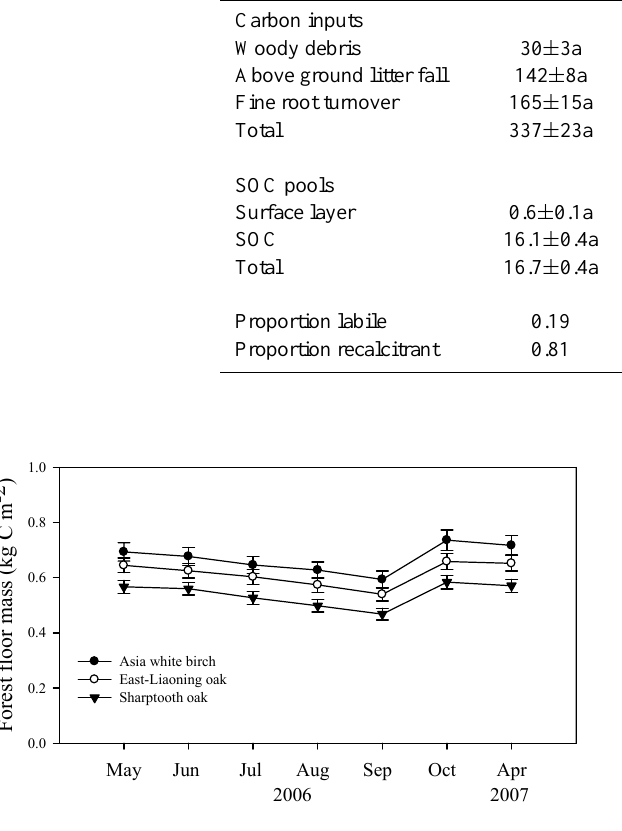
Fig. 1. Seasonal changes of forest floor mass in Asia white birch and East-Liaoning oak forests of warm temperate zone and Sharp- tooth oak forest of sub-topical zone from May 2006 to April 2007. Vertical bars indicate standard errors of means ( n =5).